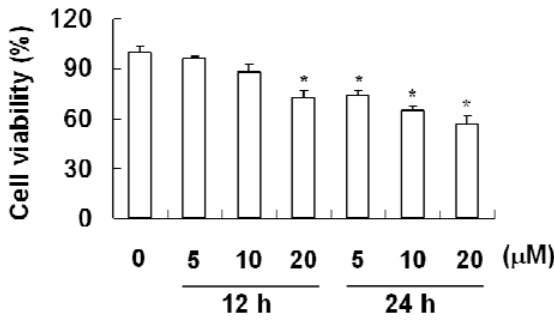
Figure 2. Representative cell viability of A549 cells treated by davallic acid at various concentrations for 12 h and 24 h, respectively. Results are expressed as mean ± SD (n = 3). * p < 0.05 was compared with the 0 µM